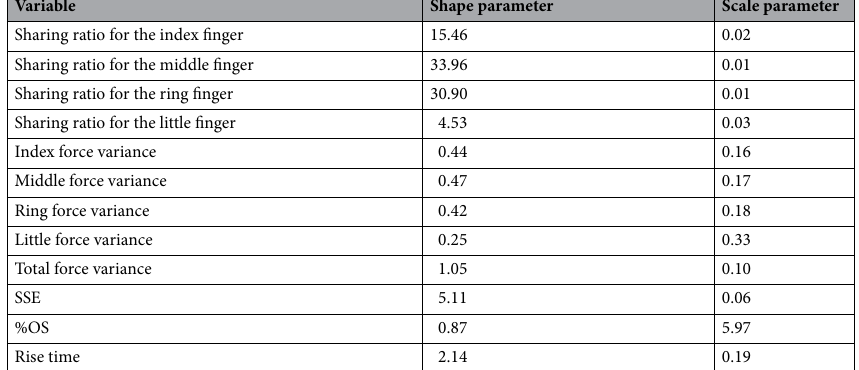
Table 1. Gamma distribution parameters for fingers’ sharing ratio, variance, and controller design specifications. Shape and scale parameters of gamma distribution for sharing ratio of individual fingers’, variances of individual and total finger force are provided. Similarly, these parameters are given for the controller design specifications, i.e., SSE, %OS, and rise time based on performance specification observed from empirical